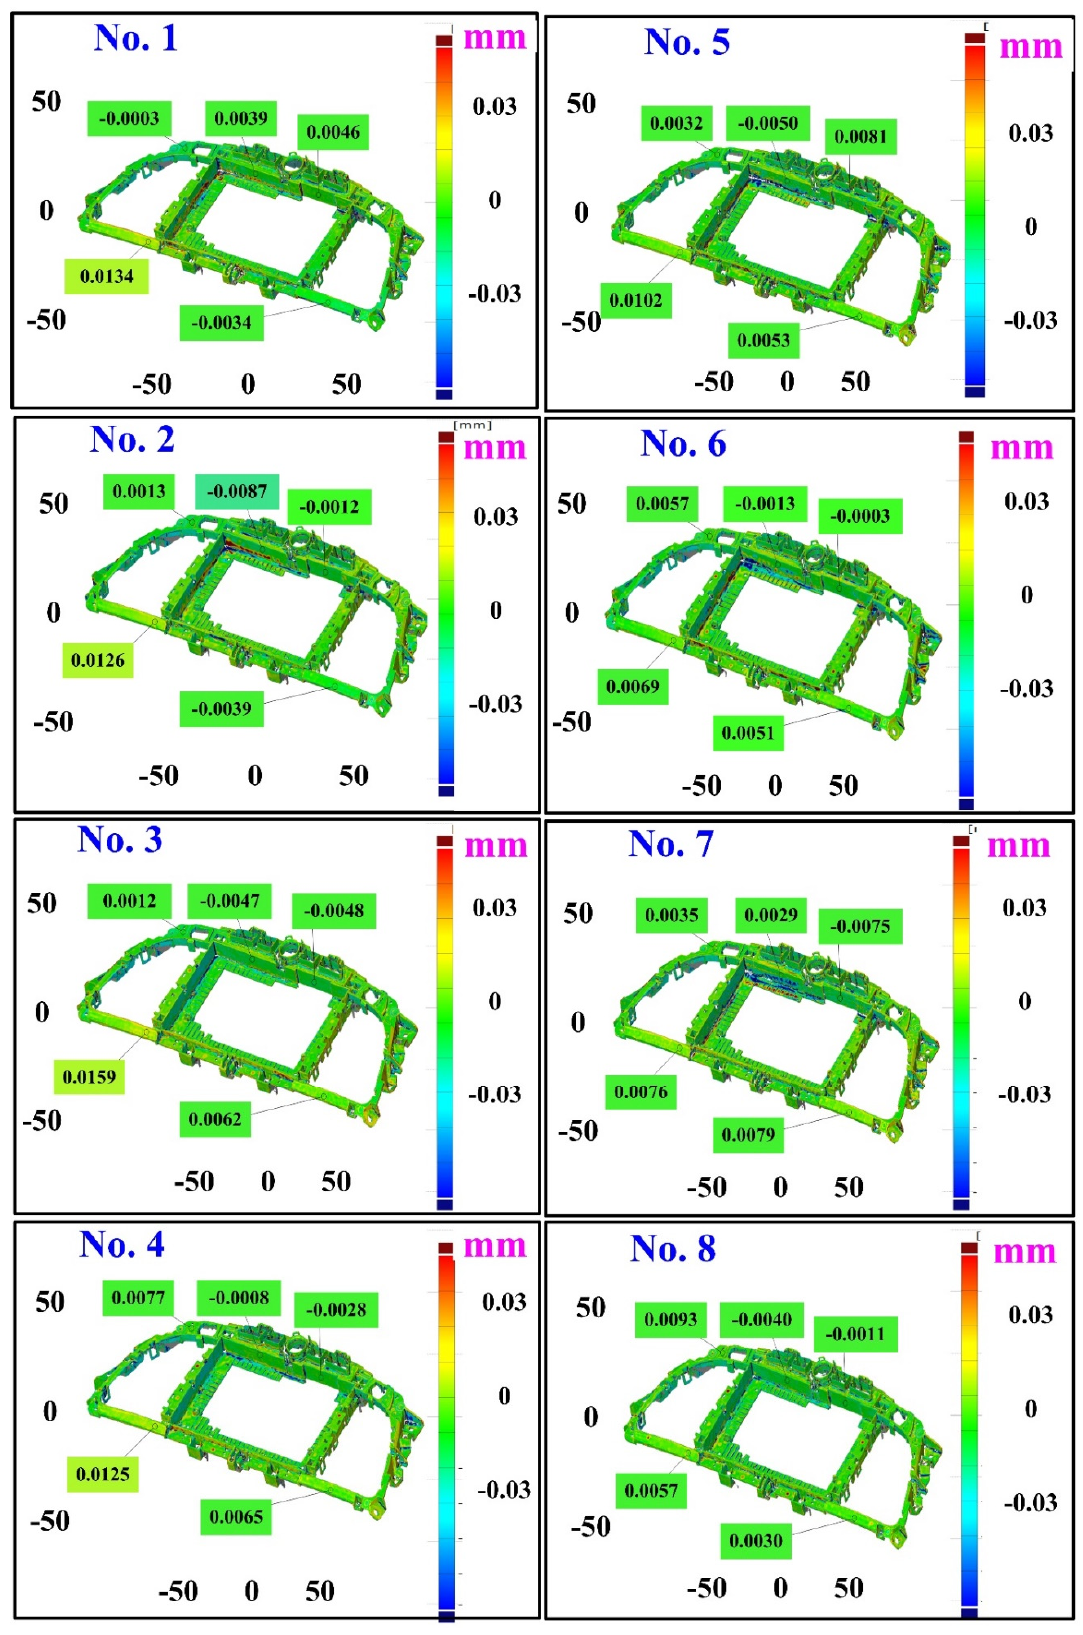
Figure 11. CAV results of dark plastic part. Data of five measurements in figure are only representative analysis results.